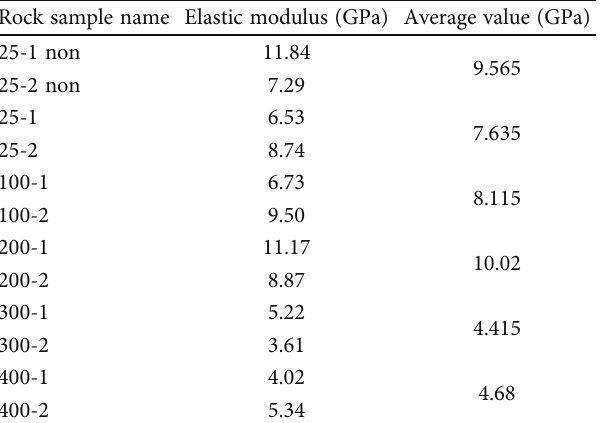
Table 3: The elastic modulus of di ff erent samples.